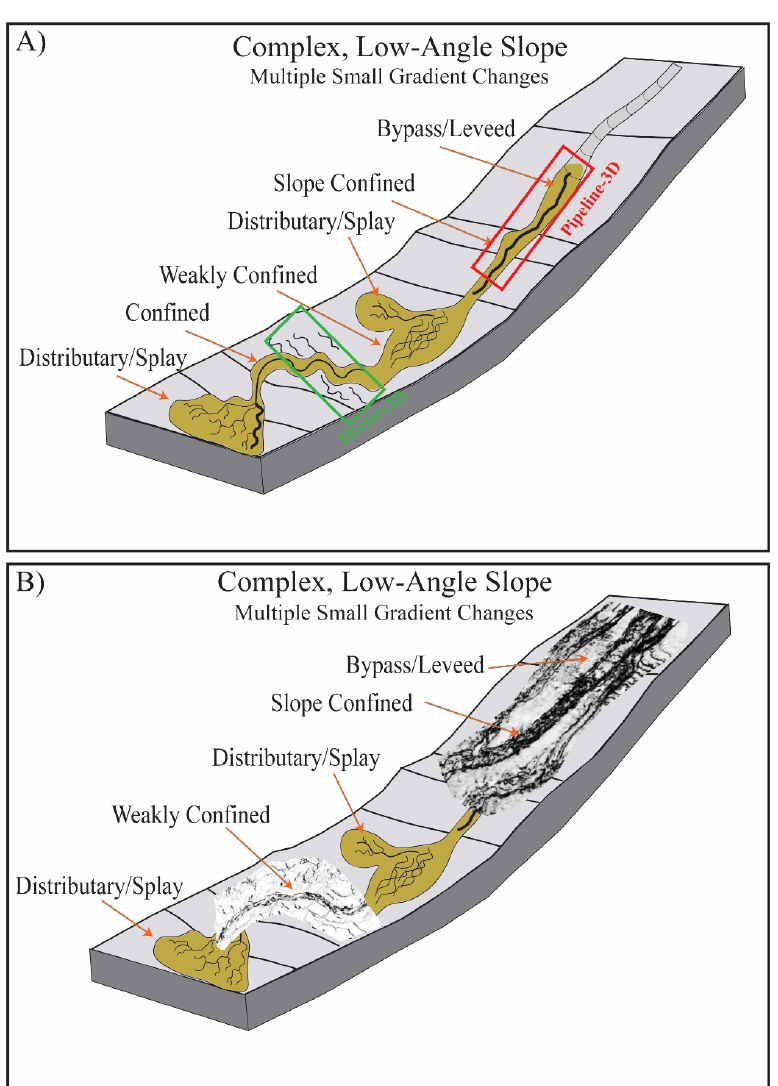
Figure 15. ( A ): Depositional model created for the region during the Lower Tt, modified after [40]. The red box corresponds to Pipeline-3D’s area, while the green box represents the location of the Hector-3D area. ( B ): Depositional model with channels from both Pipeline-3D and Hector-3D study areas overlain.